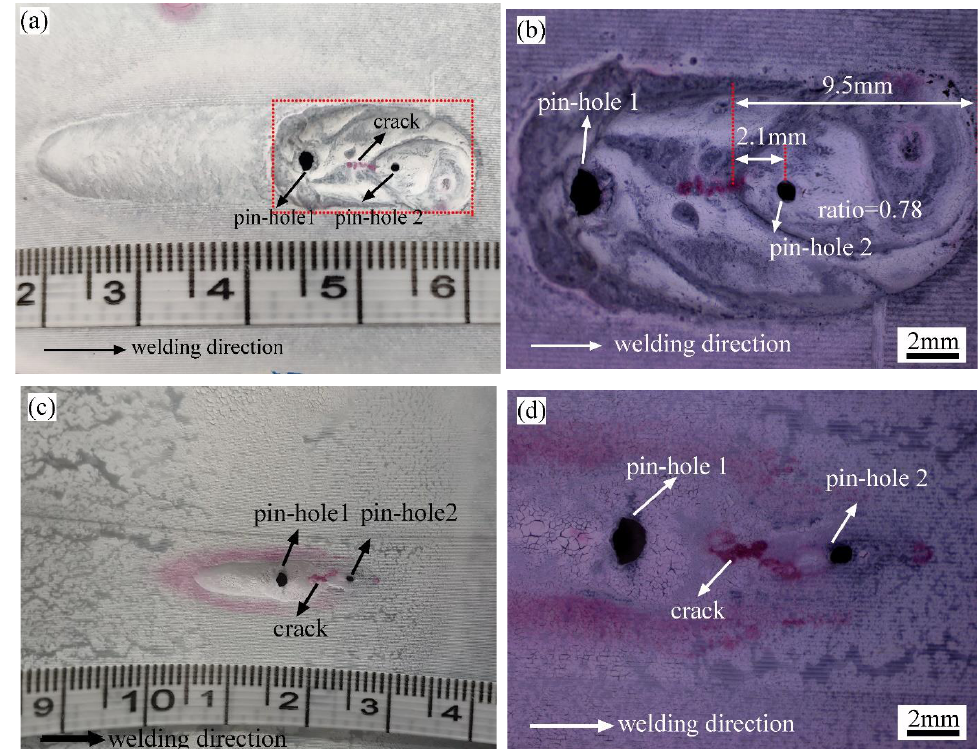
Figure 10. Macroscopic morphology and penetration inspection results near the burn-through zone: ( a ) upside; ( b ) detailed view of the burn-through zone; ( c ) backside; ( d ) detailed view of the burn- through zone.